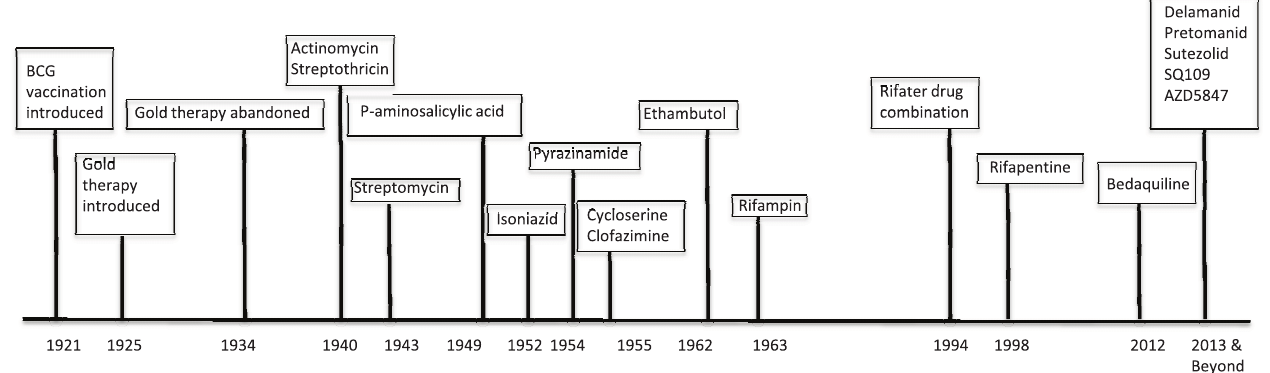
Figure 1. Timeline for tuberculosis (TB) drug development. Major milestones in TB drug development over the last century are outlined by the date of approval of the drug or intervention. Approval dates for drugs in development are estimated. Abbreviations: BCG, Bacillus